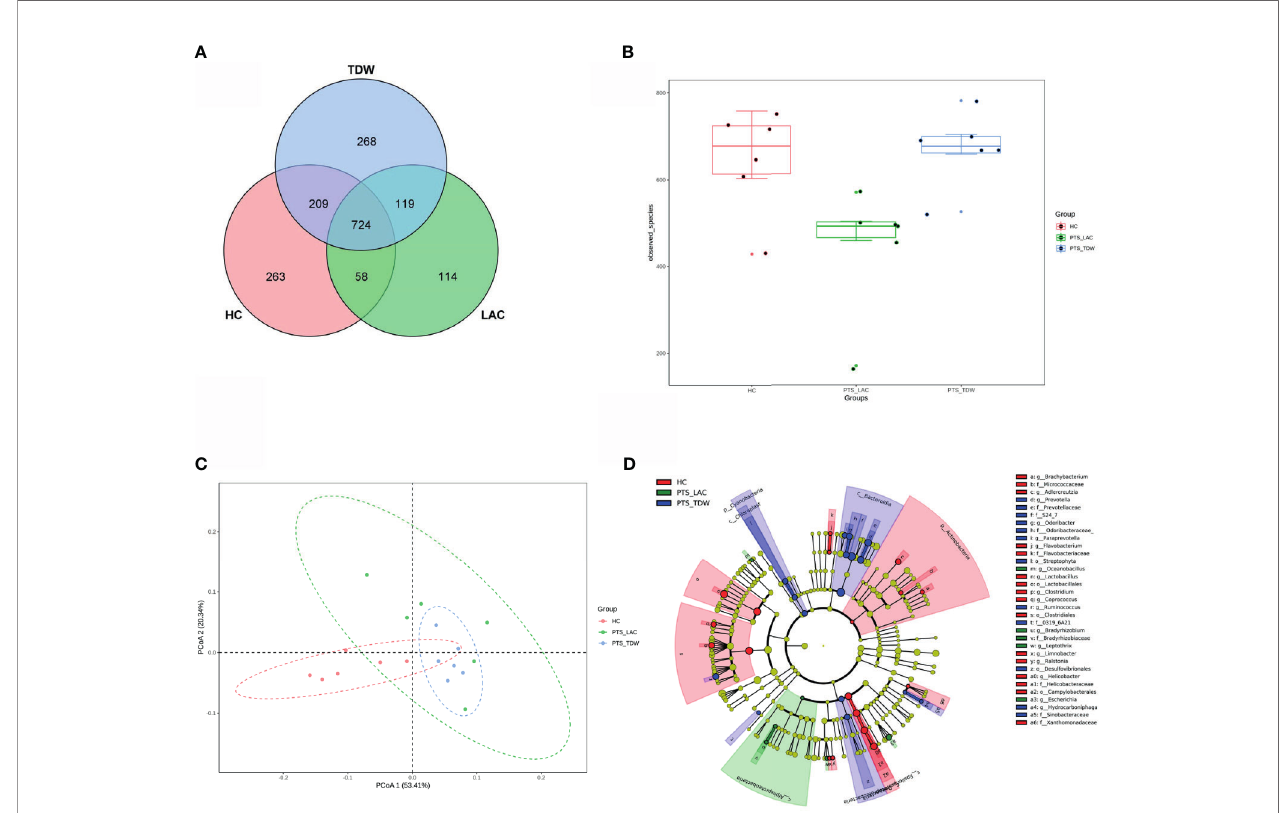
FIGURE 4 | Variations in microbiota among the three groups. (A) Venn diagram of the operational taxonomic units among the three groups. (B) Boxplots of a - diversity as measured by observed species (n = 6). (C) Variations in microbiota among the three groups according to principal coordinates analysis. (D) A cladogram of the linear discriminant analysis effect size shows signi fi cantly different taxa among the three groups from the phylum to family